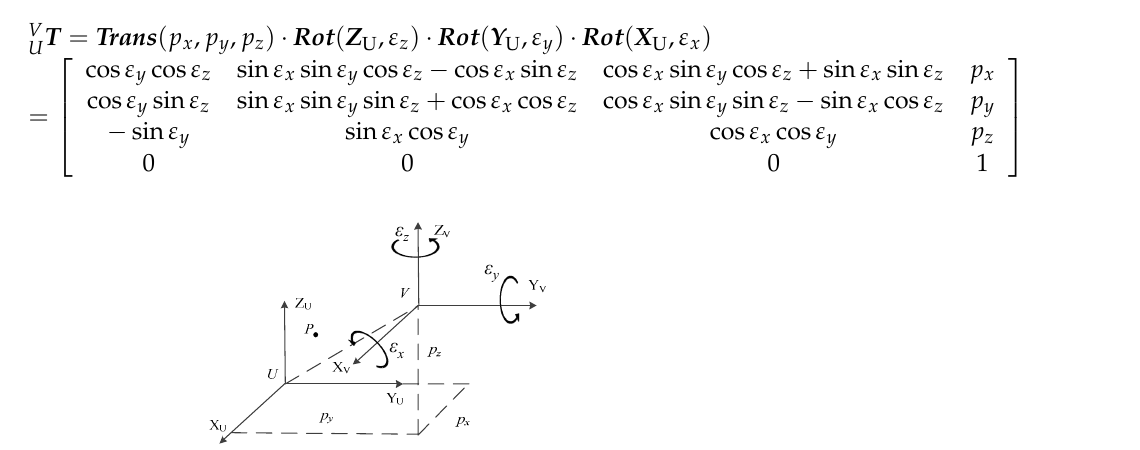
Figure 4. Coordinate transformation of coordinate system.